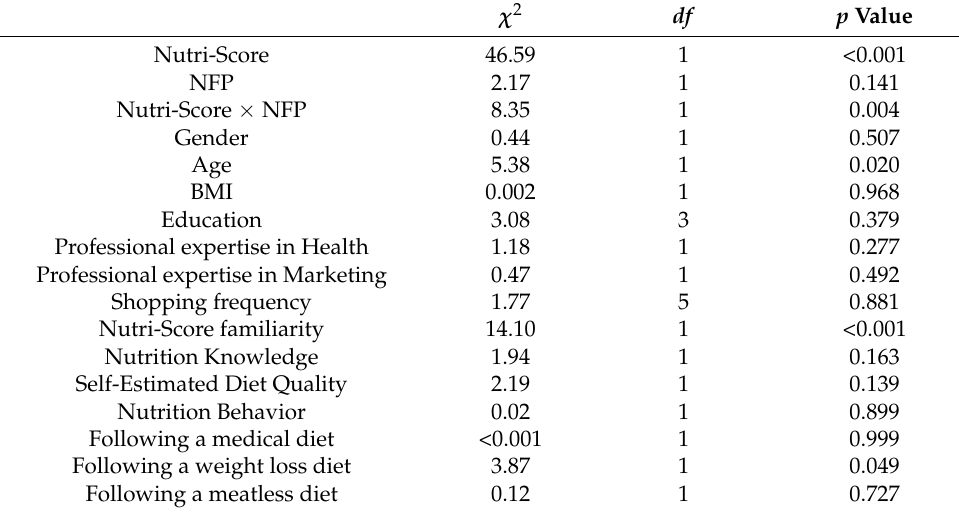
Table A3. The fixed part of the full mixed-effects model explaining